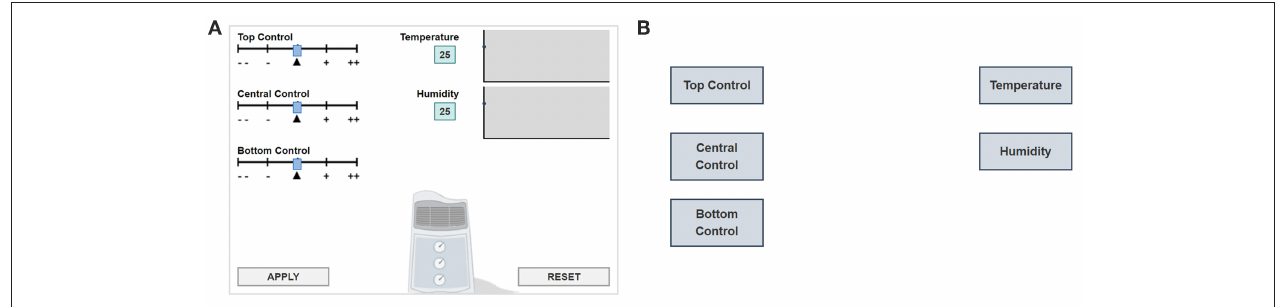
FIGURE 1 | (A) Simulation environment of CC item. (B) Answer diagram of CC item.